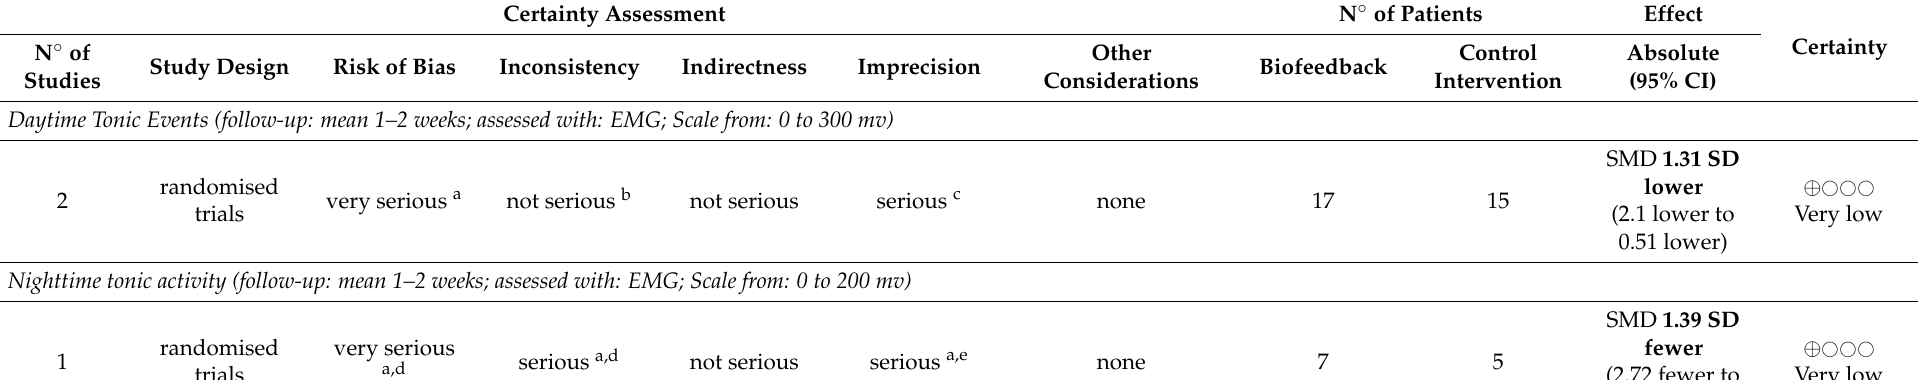
Table 2. GRADE “Biofeedback compared to control intervention for Awake Bruxism”. Certainty Assessment N ◦ of Patients Effect CertaintyN ◦ of Study Design Risk of Bias Inconsistency Indirectness Imprecision